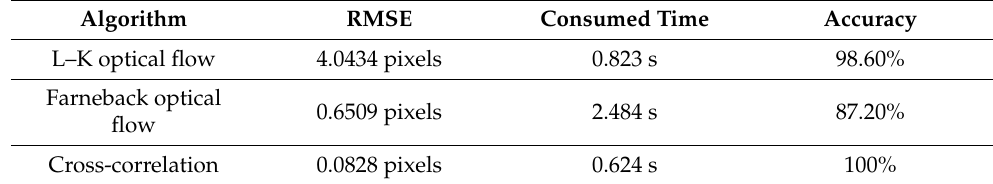
Figure 7. Displacement vector diagrams of checkerboard background. ( a ) Only 2 pixels downward, ( b ) only 2 pixels horizontally to the right, and ( c ) 2 pixels horizontally and vertically together; 1 L–K optical flow, 2 Farneback optical flow, and 3 Cross-correlation. Table 3. Evaluation index of displacement extraction for the checkerboard